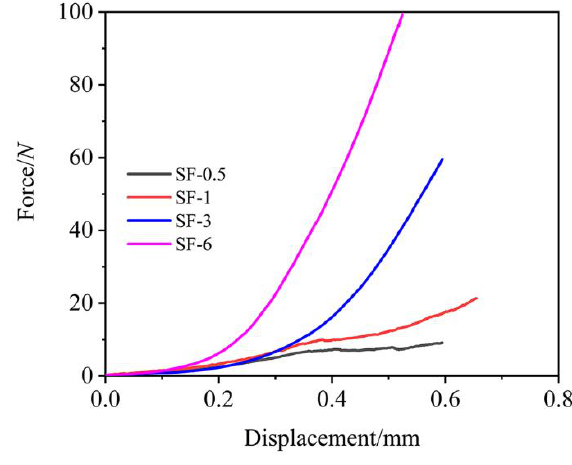
Figure 9. Compressive performance of the ceramic layer.